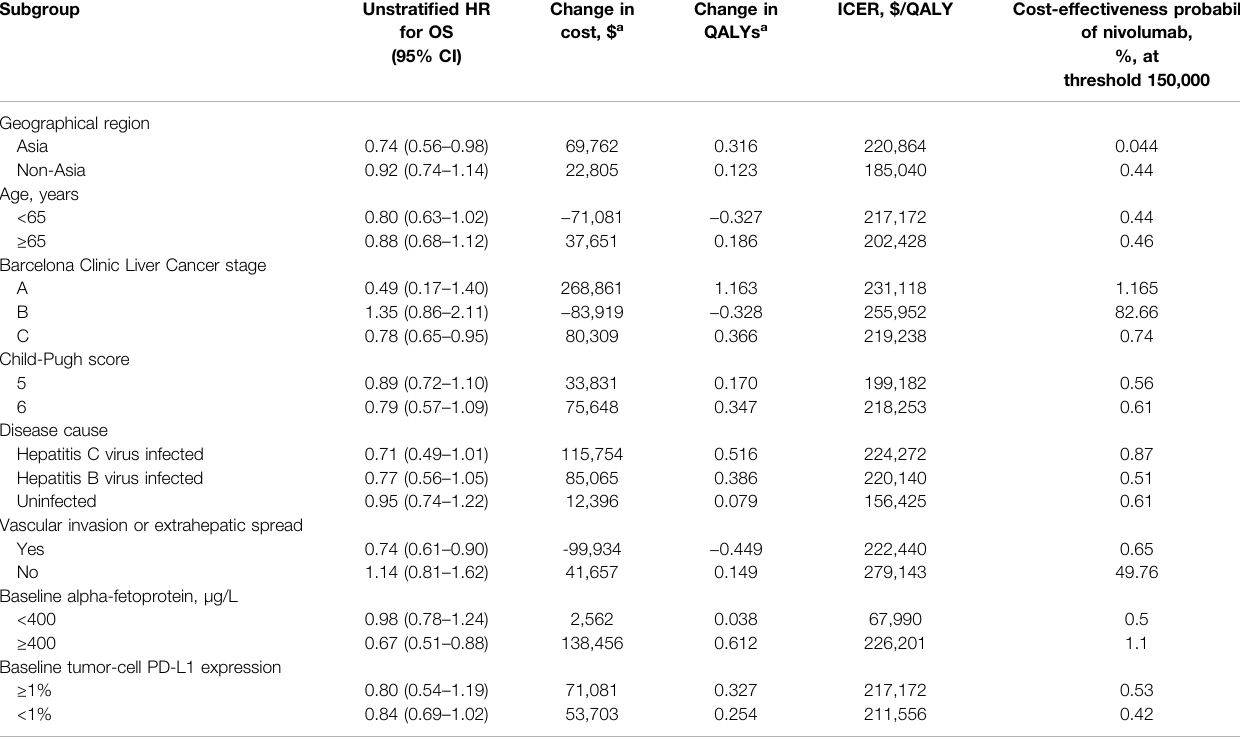
TABLE 3 | Summary of subgroup analyses obtained by varying the hazard ratios (HRs) for overall survival. Subgroup Unstrati fi ed HR